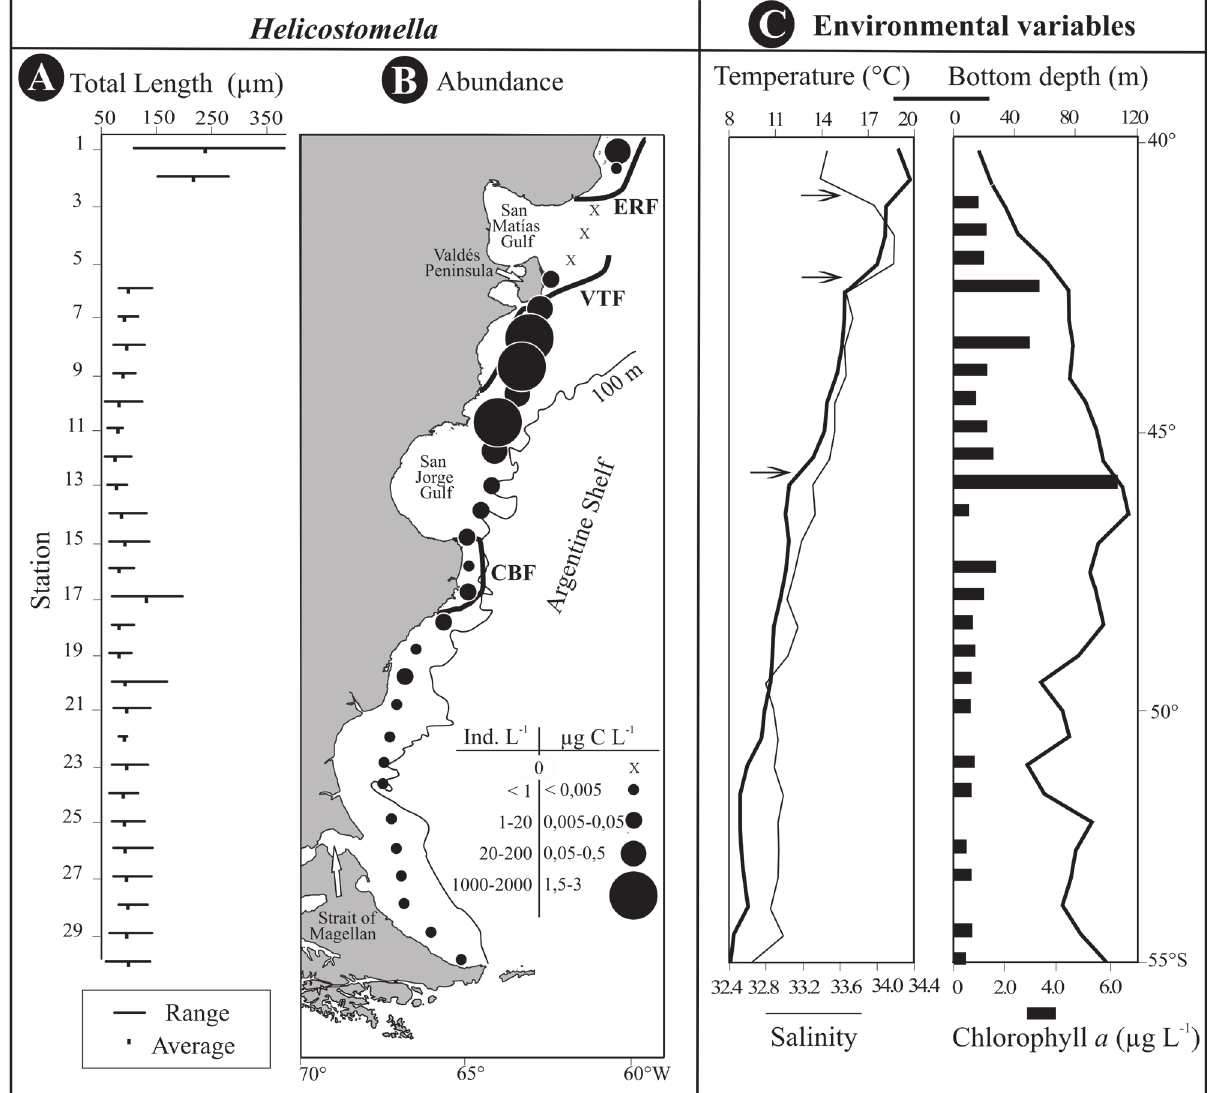
Fig . 6. – Latitudinal fluctuations of lorica length and abundance of Helicostomella , and environmental variables in the area studied. (a) Mean value and range of total length. (B) density and biomass. Lines denote historical position of fronts: el rincón front (erF), Blanco cape front (cBF) and Valdés front (VF) (Sabatini and Martos, 2002; acha et al. , 2004). (c) temperature, salinity, bottom depth and chlorophyll a concentration. arrows indicate latitudinal gradients of temperature and mum values of 9.41 µM and 1.02 µM at 54.5ºS and 49.5ºS, respectively (data not shown). chlorophyll a concentration was generally low, clearly peak- ing at 42.5-43.5°S (2.93-3.30 µg L -1 ) and at 46°S (Max: 6.30 µg L -1 ). Bottom depth varied from 16 m to 112 m, with most of the stations located in the range of 50-100 m. the results from the Pca (Fig. 7) showed that temperature, salinity and nitrate were the main variables on the first axis (66% of total variance; ev = 0.51, 0.49 and -0.51, respectively), while on the second axis the high- est weight was represented by bottom depth and nitrite (17% of total variance; ev = -0.83 and 0.43,